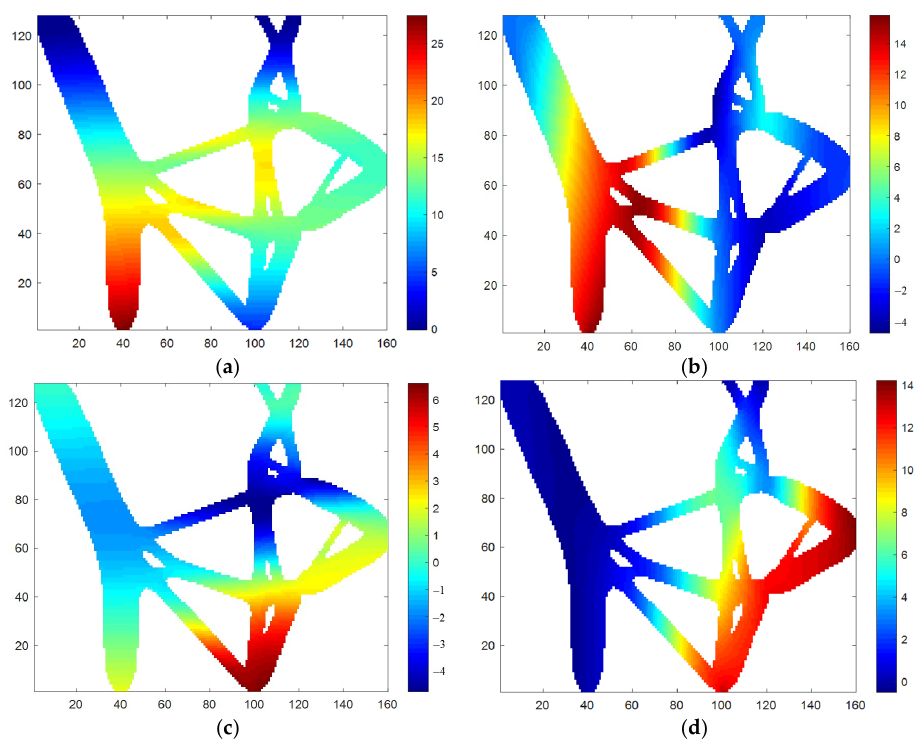
Figure 8. Obtained displacement distributions using Equation (13): ( a ) horizontal and ( b ) vertical displacement results generated by F I 1 , ( c ) horizontal and ( d ) vertical displacement results generated by F I 2 .